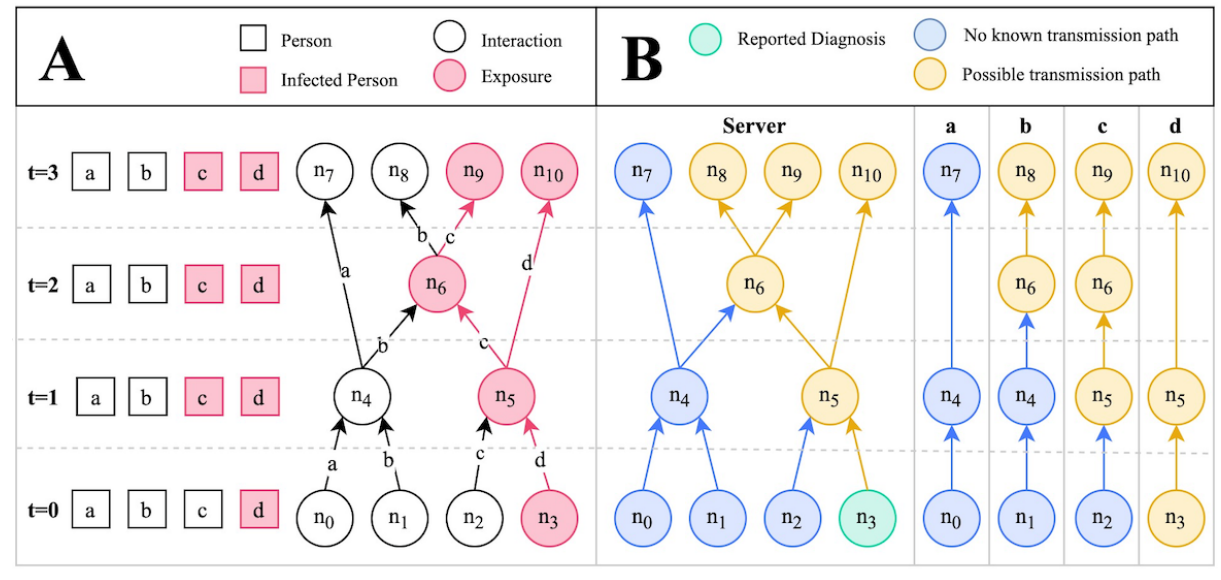
Figure 4. Disease spread scenario modeled as a transmission graph. (A) Graphical representation of a disease spread scenario across time. Contact points with infected individuals are denoted as exposures. Uninfected individuals may become infected at exposure points according to some probability (the transmission rate); hence, b does not become infected at n6. (B) Transmission graph corresponding to the scenario in A, depicting the information that is available to the server and each individual’s smartphone app. Only one node, n3, is associated with a reported diagnosis. The infection risk level at the other contact points can be inferred by checking for possible transmission paths. n: node; t: time